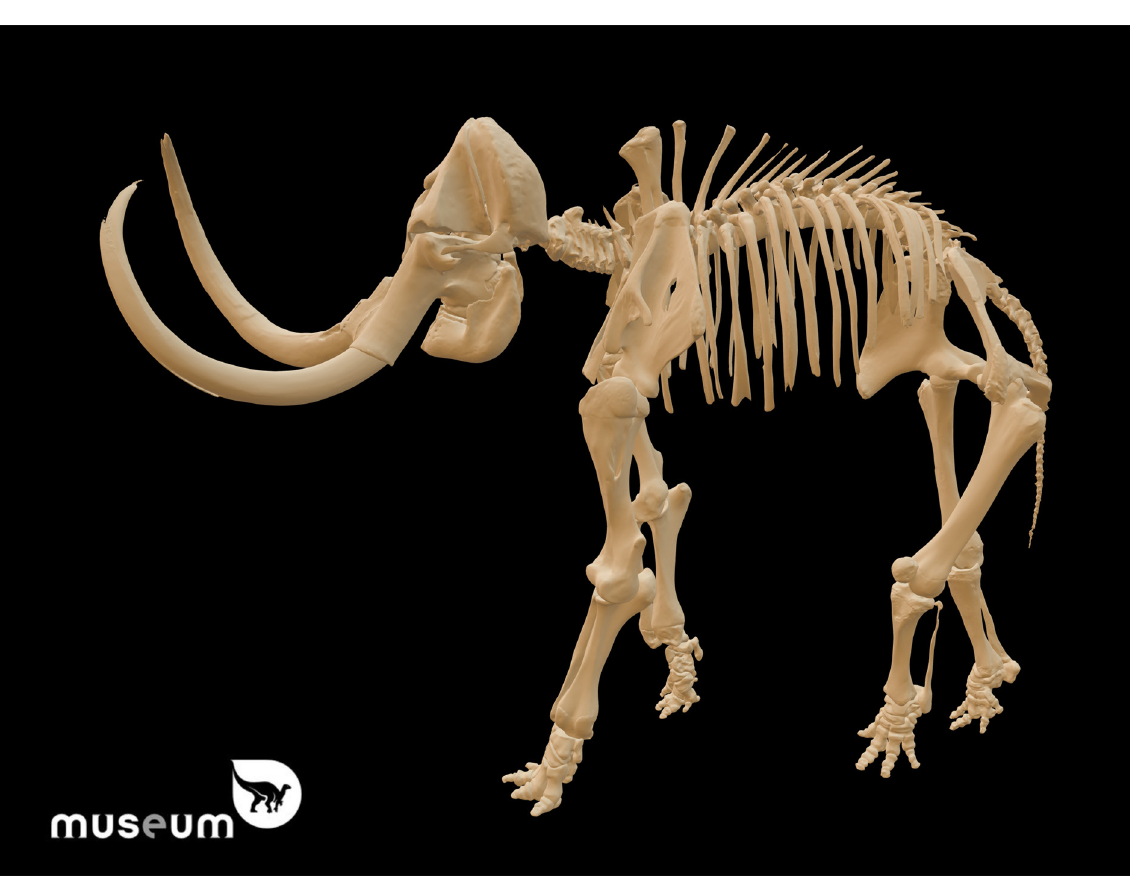
Fig. 3.36. 3D model of the mammoth on display at the RBINS permanent exhibition. The bones were scanned one by one at the moment the skeleton was disassembled to move it to another exhibition spot. The Gotcha infrared depth sensor was used and the different 3D models were virtually reassembled in lhpFusionBox (ULB, Brussels). https://sketchfab.com/models/2d25256368a44a0fb98d0418ac500d47